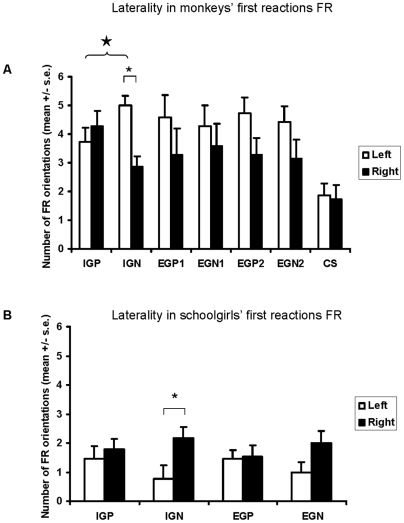
Laterality of first reactions in relation to sound categories for monkeys and girls.Values shown are the means±s.e. Stimuli – IG: intra-group, EG: extra-group, P: positive, N: negative, 1: De Brazza monkeys, 2: red-capped mangabeys, CS: control sound. Asterisk: Result of Wilcoxon test: p<0.05 Open star: Result of Fisher test: p<0.05.